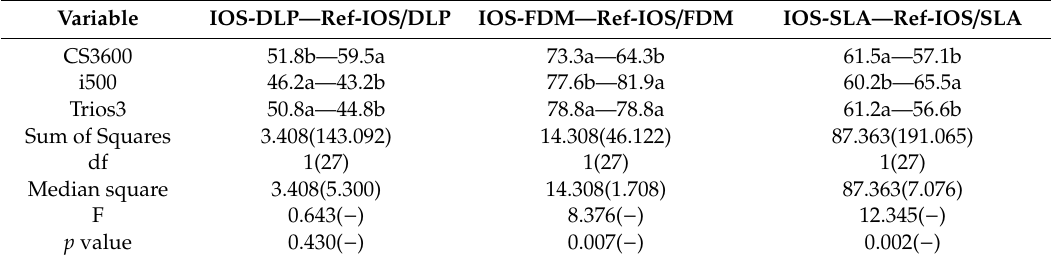
Table 4. Comparison of median trueness values of IOS-3DP and Ref-IOS / 3DP